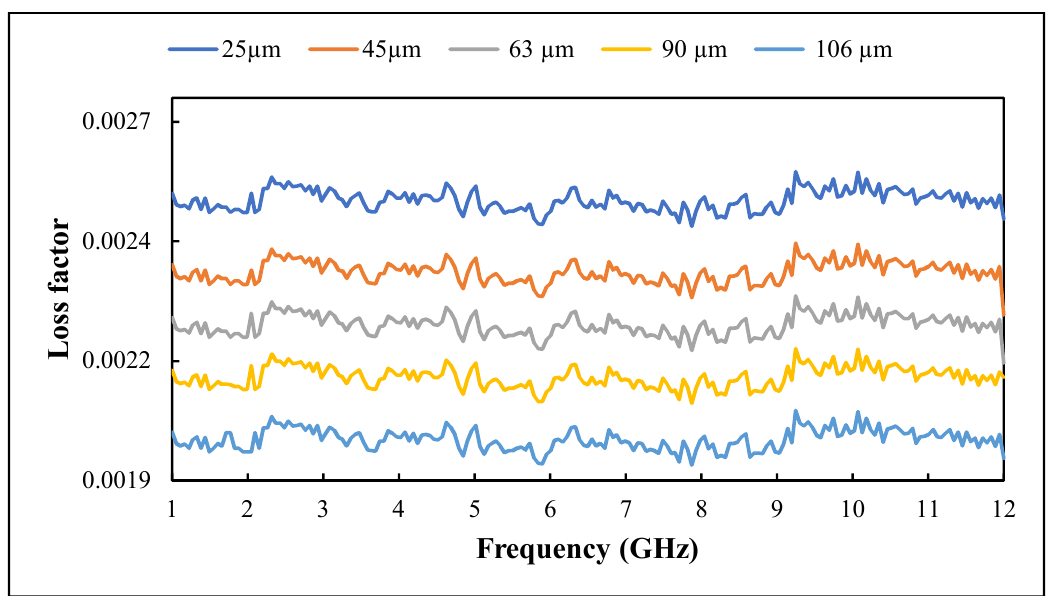
Figure 10. Variation of loss factor with filler size.